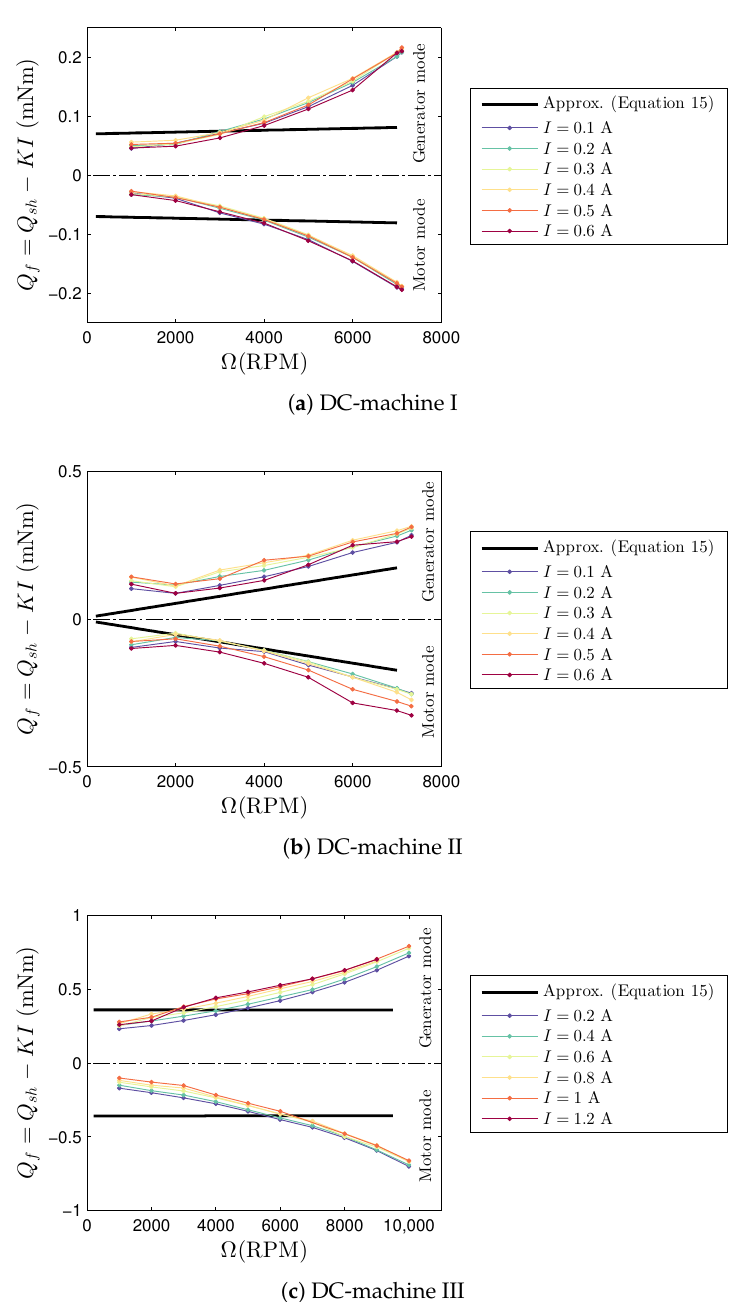
Figure 9. Measured values of ( Q sh − KI ) versus the rotational velocity Ω for different electrical currents and DC machines in both motor and generation modes. The black lines show the prediction of the friction torque Q f based on Equation (15) and using the manufacturer-provided